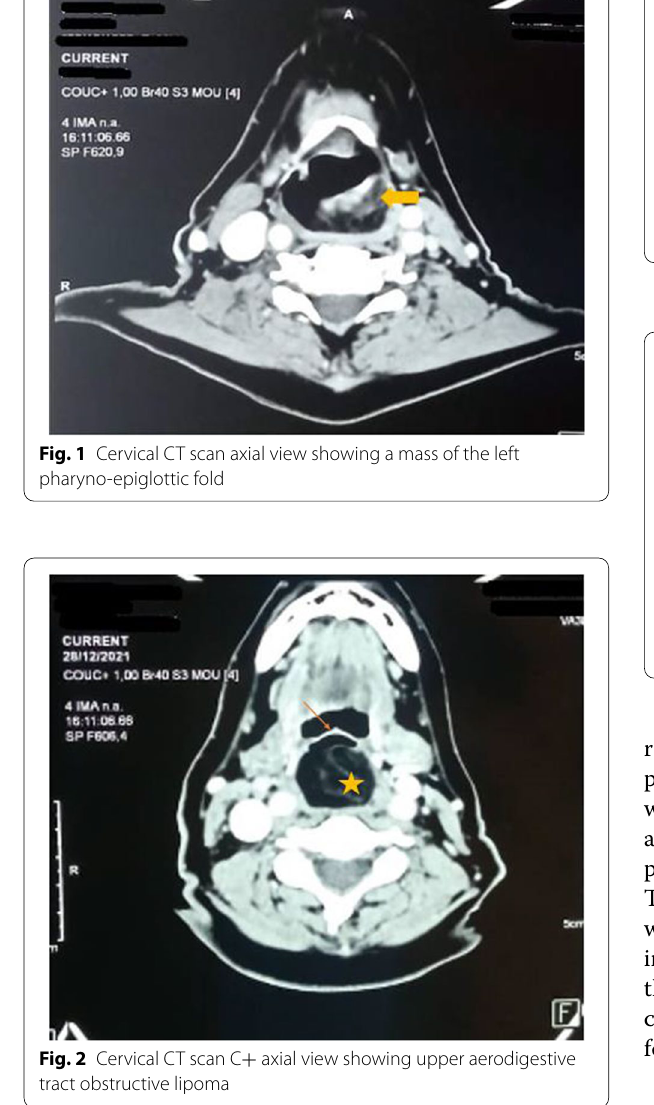
axial view showing upper aerodigestive +